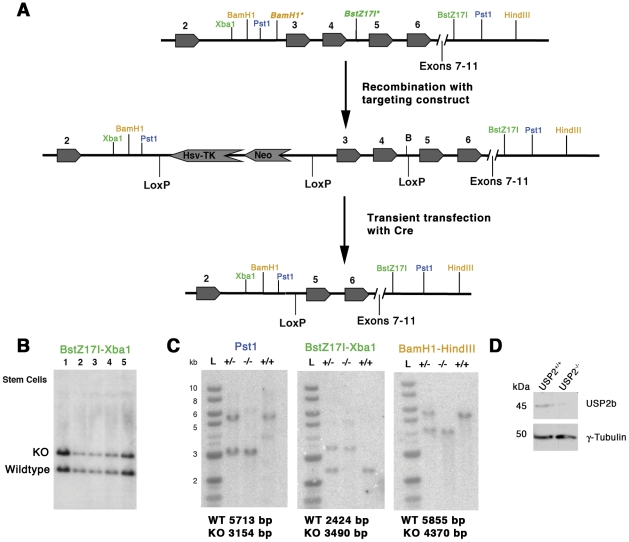
Targeted deletion of Exons 3 and 4 of the Usp2 gene.
A. A diagram of a portion of the Usp2 gene is illustrated at the top with Exon numbering based on Ensembl Gene structure of Usp2a (Usp2–201- ENSMUT00000034508). The targeting vector was constructed to introduce LoxP sites upstream and downstream of Exons 3-4 as well upstream of the thymidine kinase (TK) neomycin (NEO) cassette. The structure of Usp2b (not shown) begins with an alternative Exon 1 and Exons 3–4 correspond to Exons 2–3 in Usp2b (Usp2-202-ENSMUST00000065461). Transient transfection of targeted ES cells with a plasmid encoding Cre recombinase was expected to produce cells carrying a conventional KO allele with a single LoxP site replacing exons 3 and 4 with insertion of a stop codon [39]. Cre expression was also expected to produce a “floxed” allele (not illustrated) with LoxP sites in Intron 2–3 and 4–5 with deletion of the TK-Neo cassette [39]. Three Southern blot strategies for determining correct targeting involved restriction digests with enzymes (color coded) at the relative positions indicated in each diagram. Note that the BamH1 site 5′ of Exon 3 and BstZ17I site 3′ of Exon 4 (each marked by an asterisk) were deleted from the wildtype gene by the targeting strategy. The probe used in the Southern blots in B and C covered a region spanning spanning Exons 9 through 11 (not shown in the diagrams). B. Southern blots of BstZ17I-Xba1 (coded green) digests from five sets of heterozygous stem cells obtained after Cre recombinase transfection and used to generate chimeric mice in the Medical College of Wisconsin transgenic facility. Owing to the loss of a BstZ17I site during targeting the conventional KO allele (3490 bp) is larger than the wildtype allele (2424 bp) using this enzyme pair. C. Germ line transmission in mice was obtained only for the conventional KO and is shown by Southern blotting of individual USP2+/+, USP2+/− and USP2−/− mice using 3 different restriction digest strategies (Pst1; coded blue, BstZ17I-Xba1; coded green, and BamH1-HindIII; coded orange). Expected sizes of labeled DNA fragments for WT and KO alleles are indicated below each of the three blots. The size of the targeted allele in the BstZ17I-Xba1 and BamH1-HindII digests is caused both by loss of Exons 3 and 4 and loss of a BstZ17I and BamH1 site during targeting. The structure of the targeted allele was verified by genomic DNA sequencing. D. Western blot for USP2b and γ-tubulin from the retina USP2+/+ and USP2−/− mice at ZT12. USP2a protein was undetectable in USP2−/− mice, but a faint immuno-reactive band is seen in the USP2-/- lane.